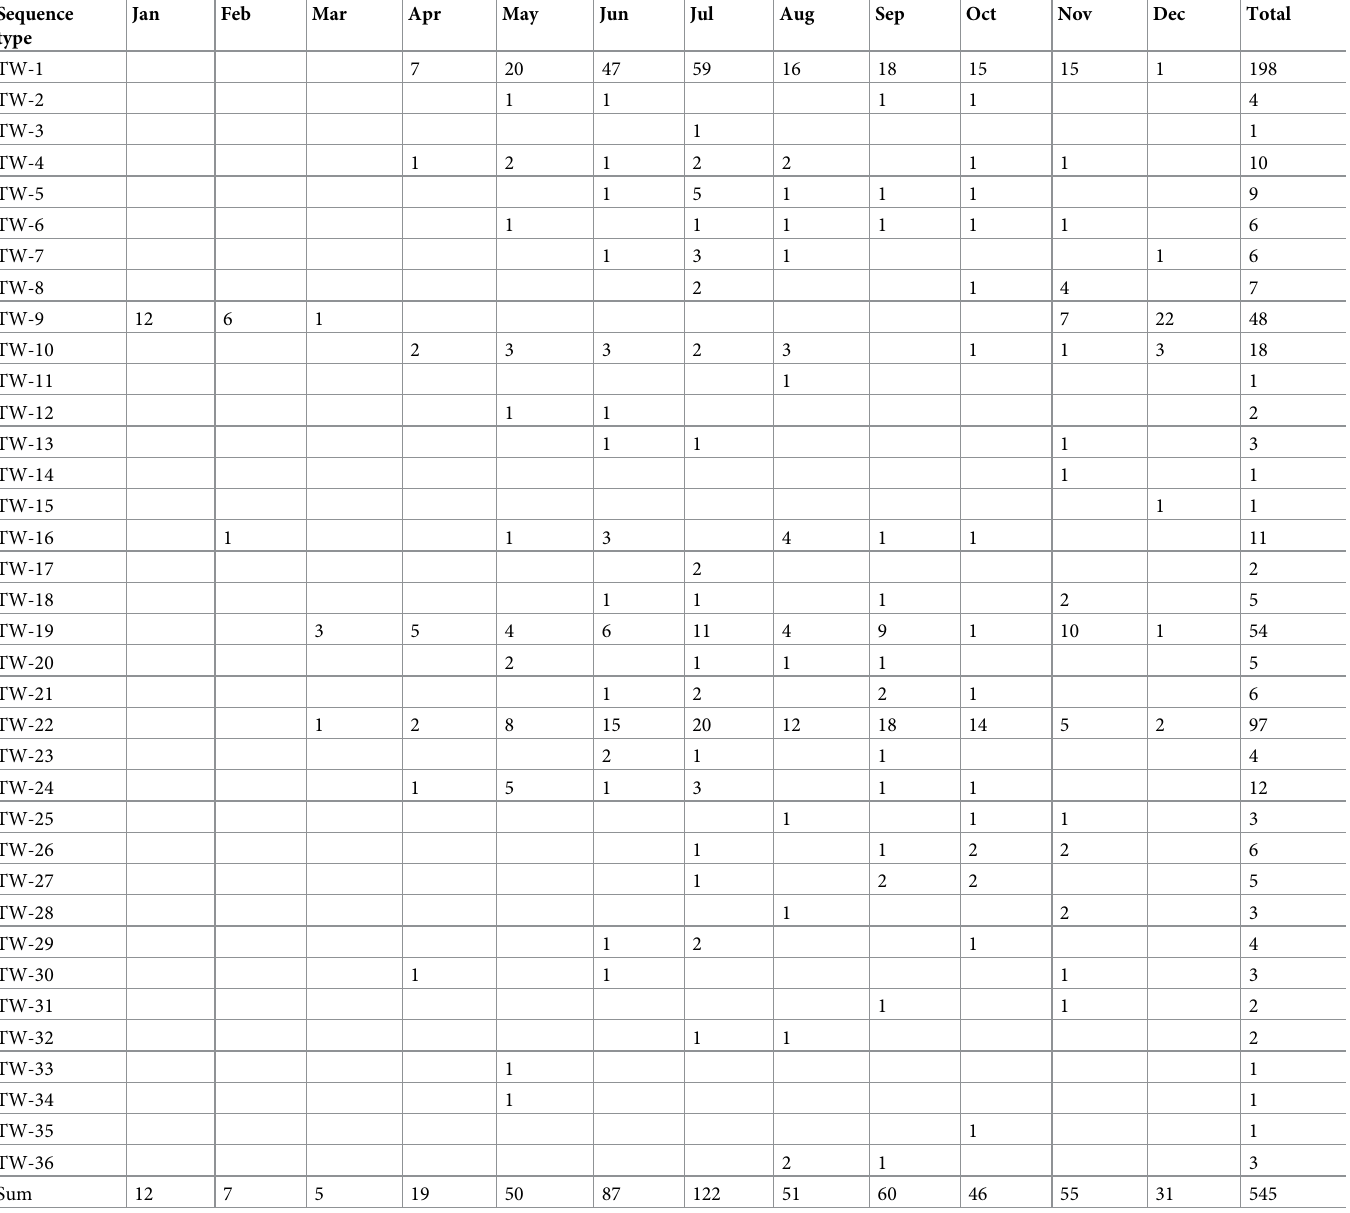
Table 3. Monthly distribution of Orientia tsutsugamushi sequence types in